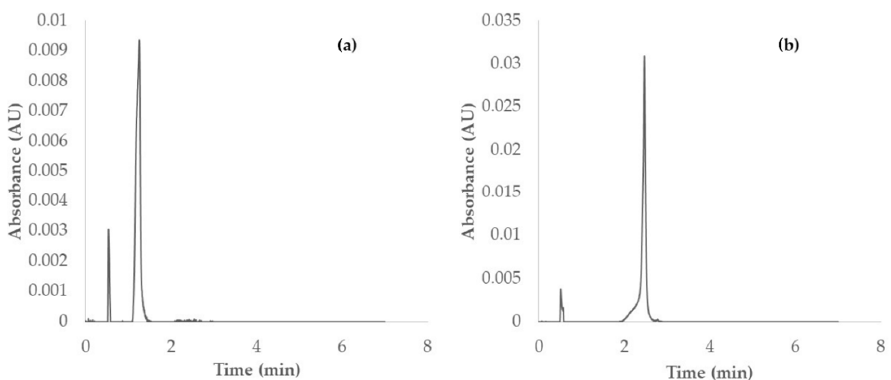
Figure 1. ( a ) Chromatogram of psilocybin at λ = 260 nm; ( b ) chromatogram of psilocin at λ = 260 nm.